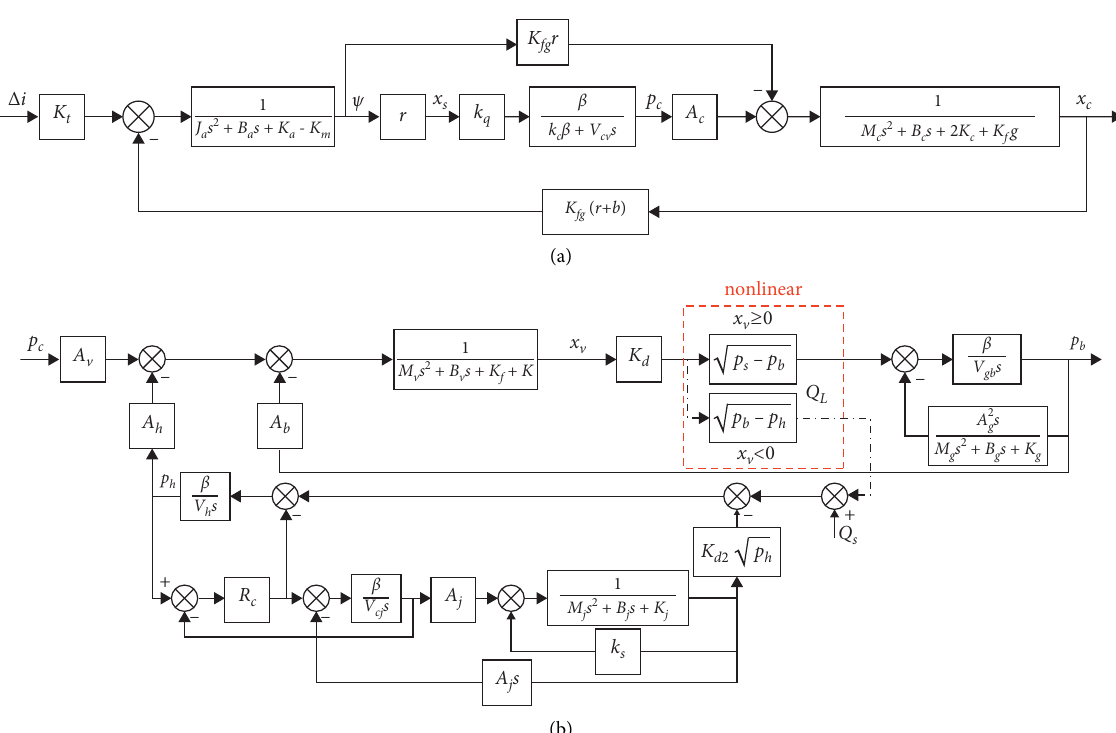
Figure 3: Te structure of brake pressure servo valve-controlled cylinder. (a) Te control structure of brake pressure servo valve pilot stage. (b) Te control structure of brake pressure servo valve power